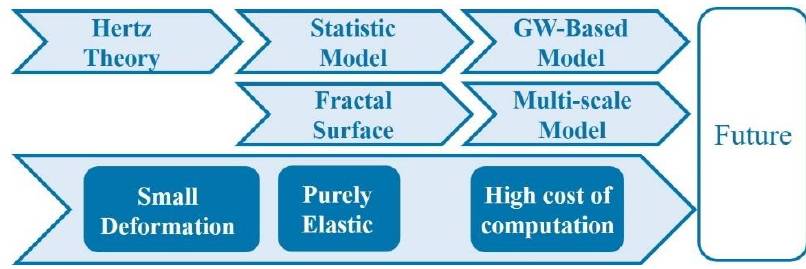
Figure 8. Two parallel modeling methods and limitations.